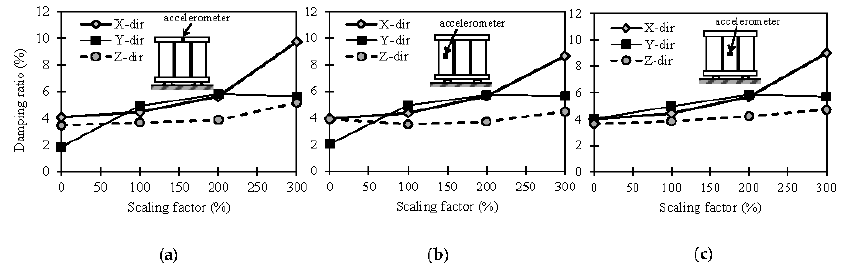
Figure 10. Variation of damping ratio of test specimen evaluated based on acceleration data at different locations. ( a ) At top beam; ( b ) At left coil; ( c ) At center coil.